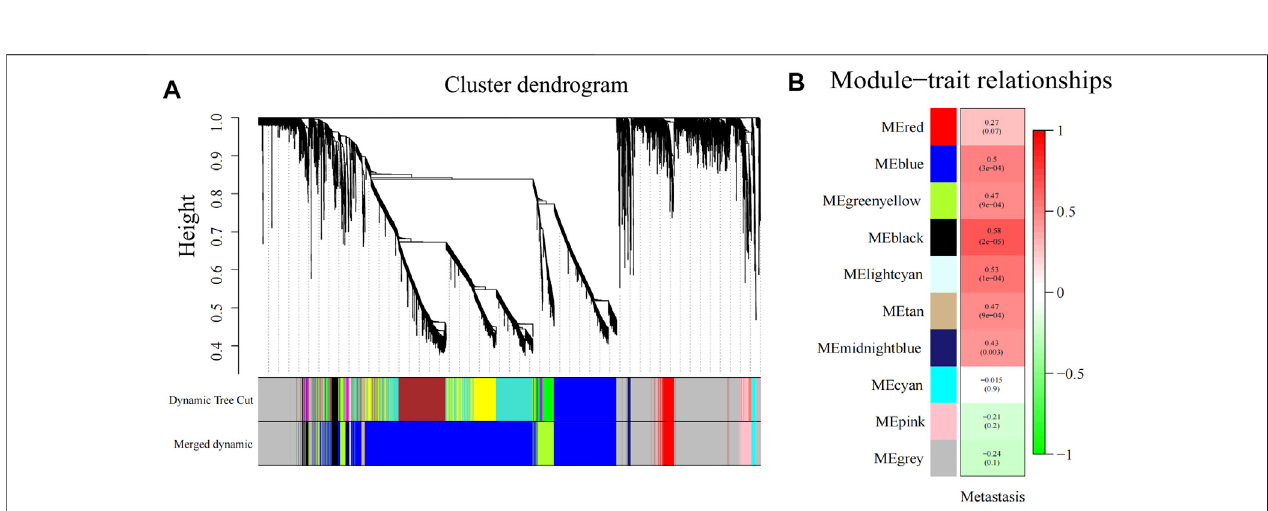
FIGURE 4 | Gene modules identi fi ed by WGCNA. (A) Gene dendrogram obtained by clustering the dissimilarity based on consensus topological overlap with the corresponding module colors indicated by the color row. (B) Heatmap of correlation between the module eigengenes and gene modules. WGCNA, weighted gene co- expression network analysis; ME, module